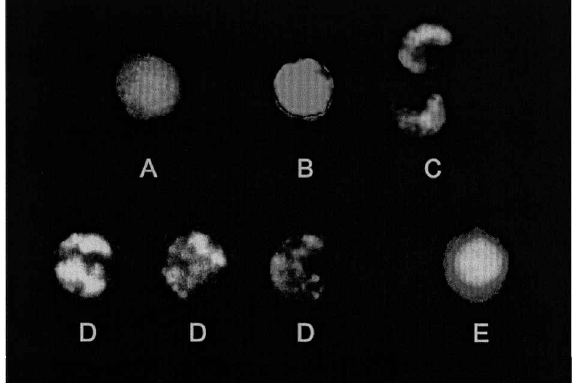
FIG. 1. Apoptotic morphological changes in mononuclear cells stained with orange acridine and ethidium bromide. A – alive lymphocyte; B – D different morphological changes in apoptotic lymphocytes; E – necrotic lymphocyte. (Fluores- cence microscope;